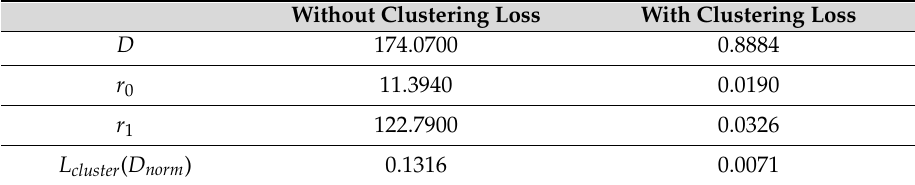
Figure 10. The features output clustering chart, ( a ) CNN with clustering loss; ( b ) CNN without clustering loss. Table 4. The clustering performance comparison.